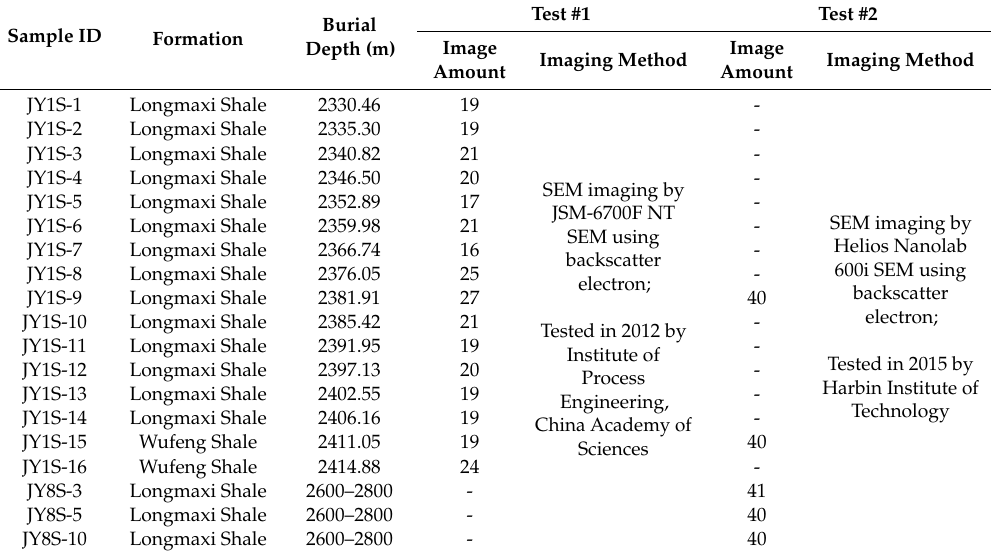
Figure 1. The structural features of the eastern Sichuan Basin ( a ) and the stratigraphy of wells JY1 and JY8 with organic matter richness and porosity ( b ). The structural feature was modified by Zhigang Wang [26] and the stratigraphic column was modified from [27]. Table 1. SEM Images of Longmaxi-Wufeng Shale of Core Samples from Wells JY1 and